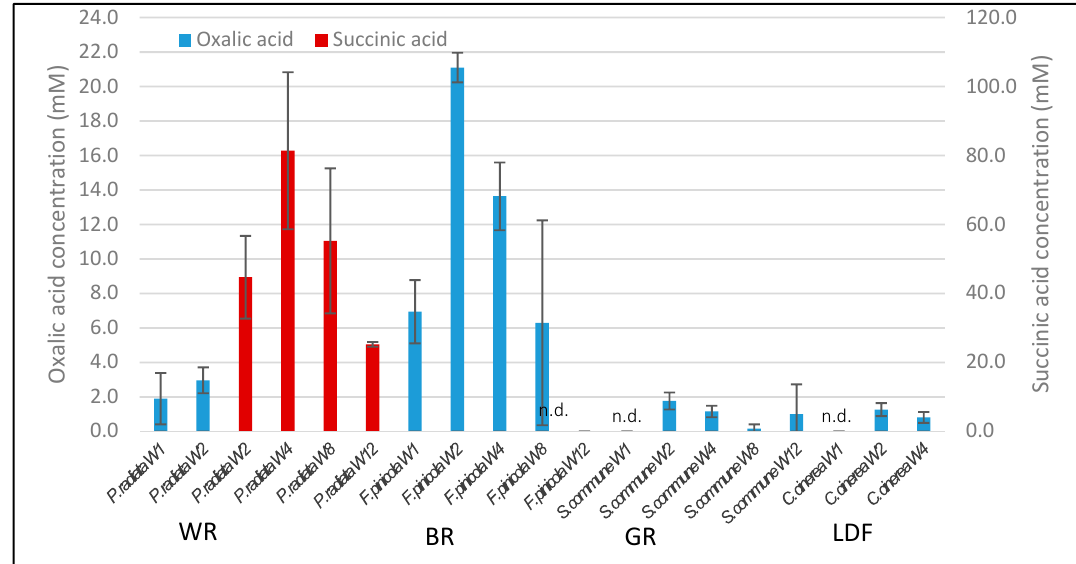
S. commune ; ( d ) LDF C. cinerea . Fungal cultivations were performed on birch wood (blue line with spheres) or barley straw (black line with spheres), and on liquid ME medium (orange line with spheres). Values from control incubations of birch wood (blue triangles, dotted line), barley straw (black triangles, dotted line) and liquid ME medium (orange triangles, dotted line) without fungi are included. Mean value ( n = 3) is presented at each week time point. Bars indicate the standard error.